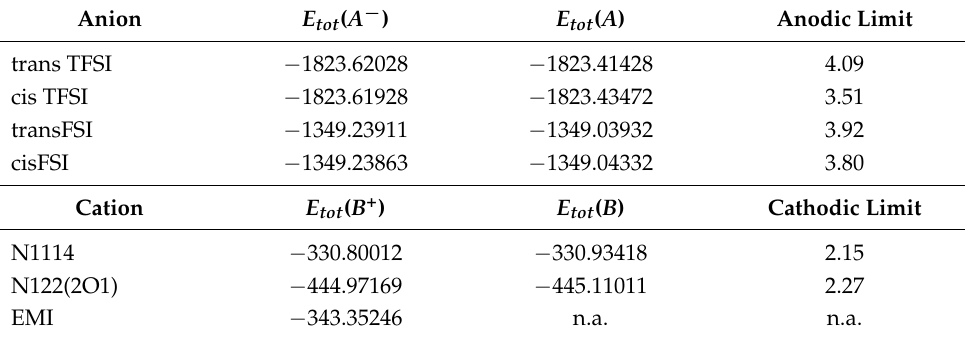
Table 5. Gibbs energy (in atomic units) of anions and cations and their relaxed neutral forms calculated at the MP2/6-31G** level of theory and derived anodic or cathodic limit (V). Anion E tot ( A −